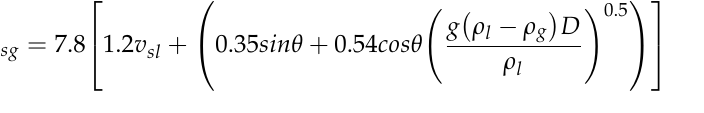
Figure 7. The boundary for discrimination of the transition from slug flow to turbulent flow.